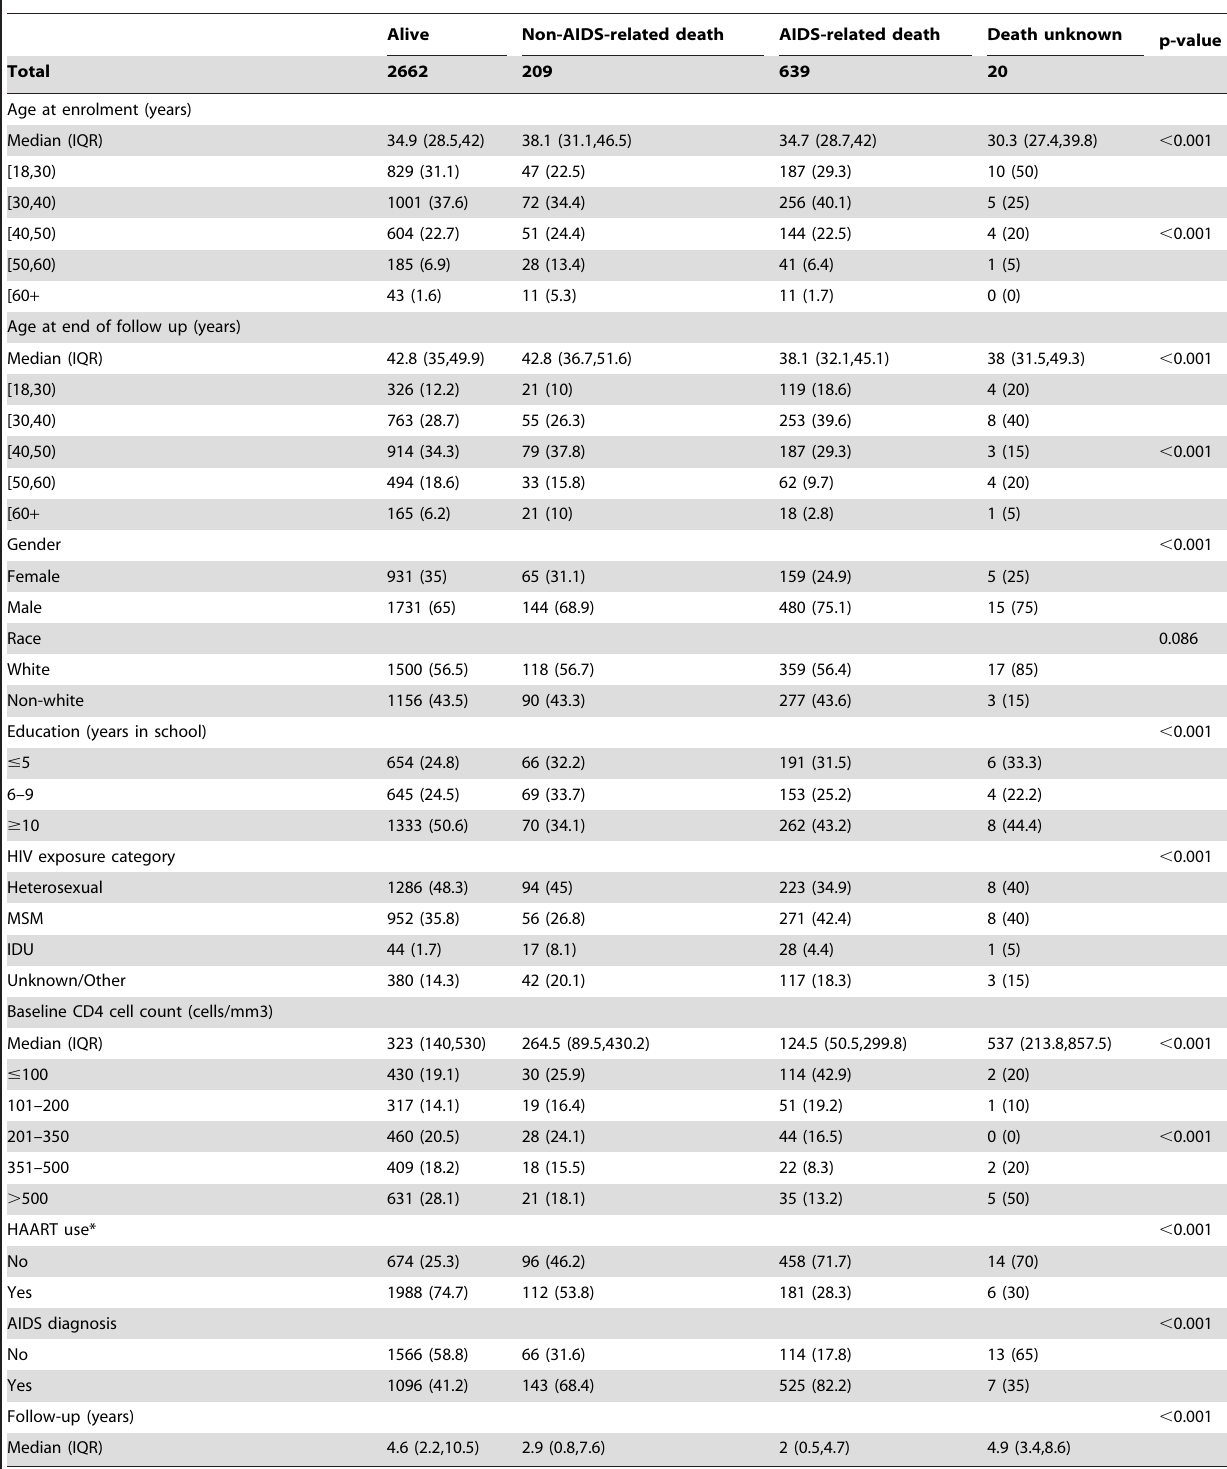
Table 1. Demographic and clinical characteristics of the study population by vital status and cause of death.